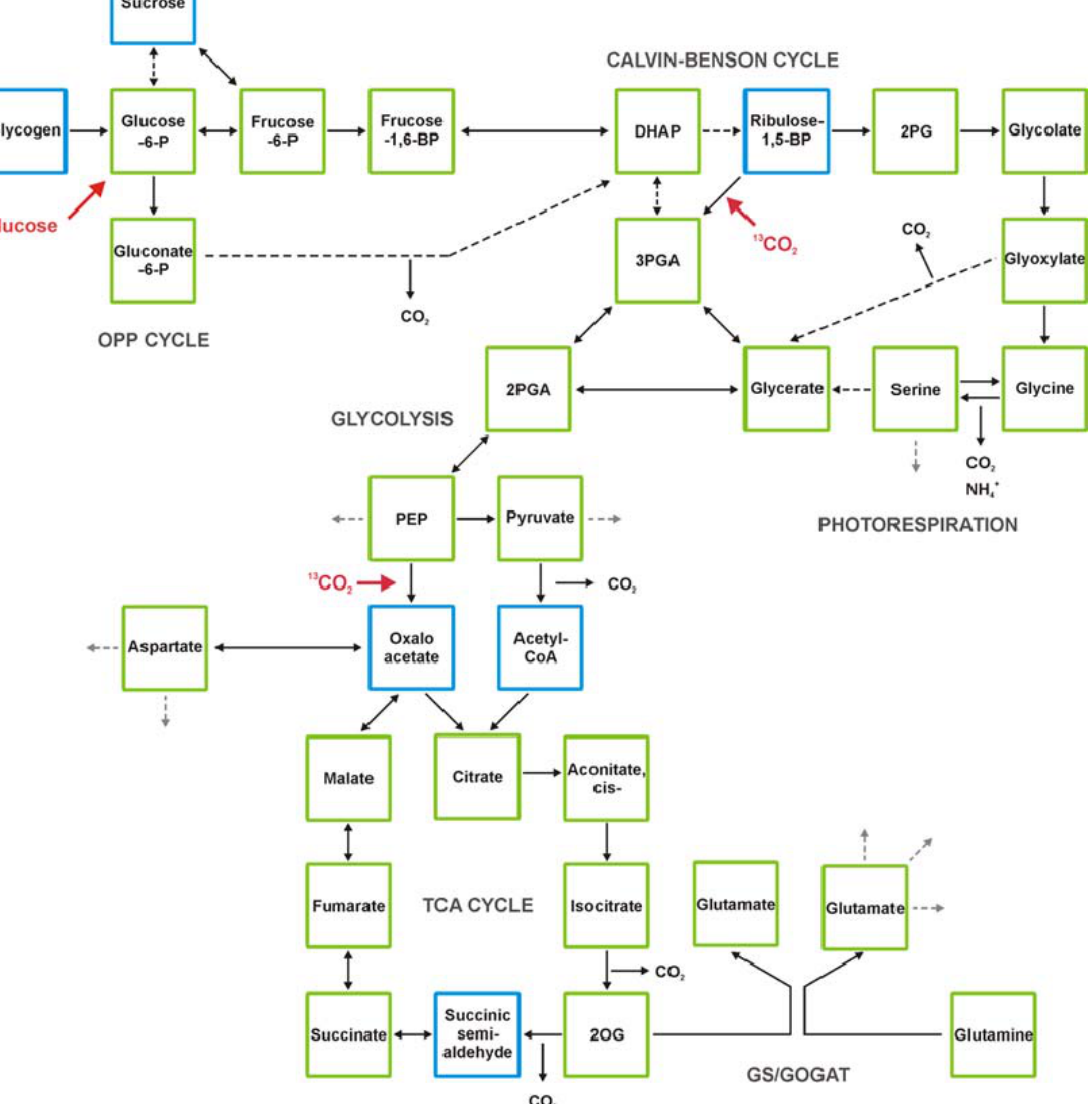
Figure 1. The primary metabolism of cyanobacteria and major entry points for inorganic carbon or glucose as organic carbon source (shown in red). Cyanobacteria such as Synechocystis 6803 fix CO mostly via the Calvin-Benson cycle, which is linked to the 2 photorespiratory 2PG cycle. Organic carbon is exported to the sugar metabolism and eventually stored as glycogen, which is used as carbon source during the night via the oxidative pentose phosphate (OPP) cycle and finally respiration. Organic carbon also can be channeled into glycolysis and tricarboxylic acid (TCA) cycle mostly to produce carbon skeletons for biosynthetic purposes. The molecule 2-oxoglutarate (2OG) is taken as precursor for ammonium assimilation via glutamine-synthetase/glutamine-oxoglutarat- aminotransferase (GS-GOGAT) and represents the main link to nitrogen metabolism. Green squares label metabolites detected by gas-chromatography-mass-spectrometry (GC-MS) [22,51]. Blue squares show as for now non-detected metabolites by GC-MS. Dihydroxyacetone phosphate (DHAP), 2-phosphoglycolate (2PG), 3-phosphoglycerate (3PGA), 2-phosphoglycerate (2PGA), Phosphoenolpyruvate (PEP), 2-oxoglutarate